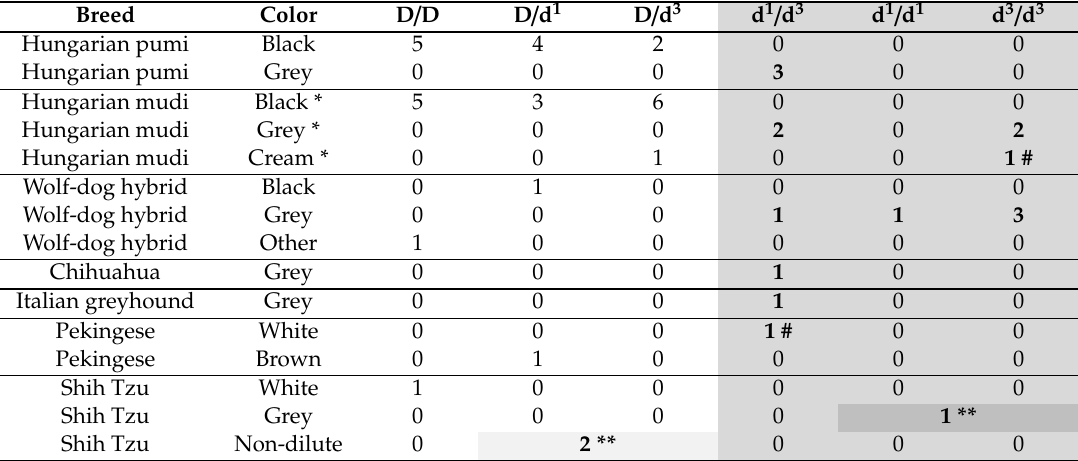
Table 1. MLPH variant genotypes in phenotyped dogs.